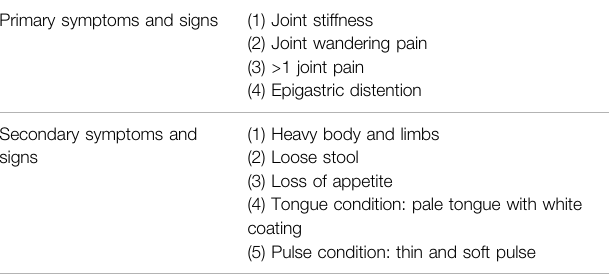
TABLE 2 | Diagnostic criteria of spleen de fi ciency and wind-damp blockade syndrome. Primary symptoms and